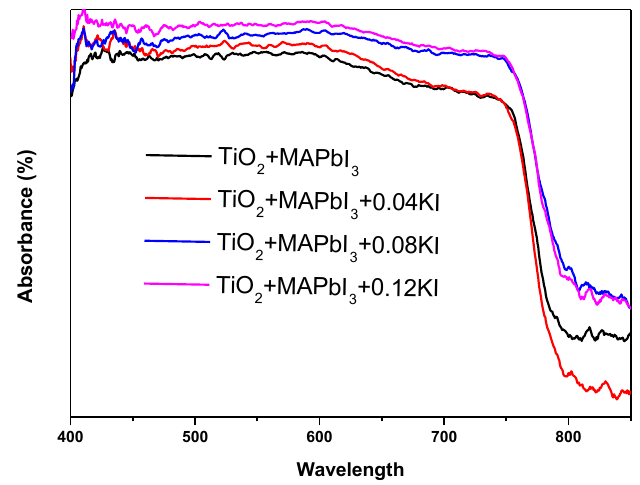
Figure 5. UV-vis absorption spectrum of perovskite layer with di ff erent K + concentrations.